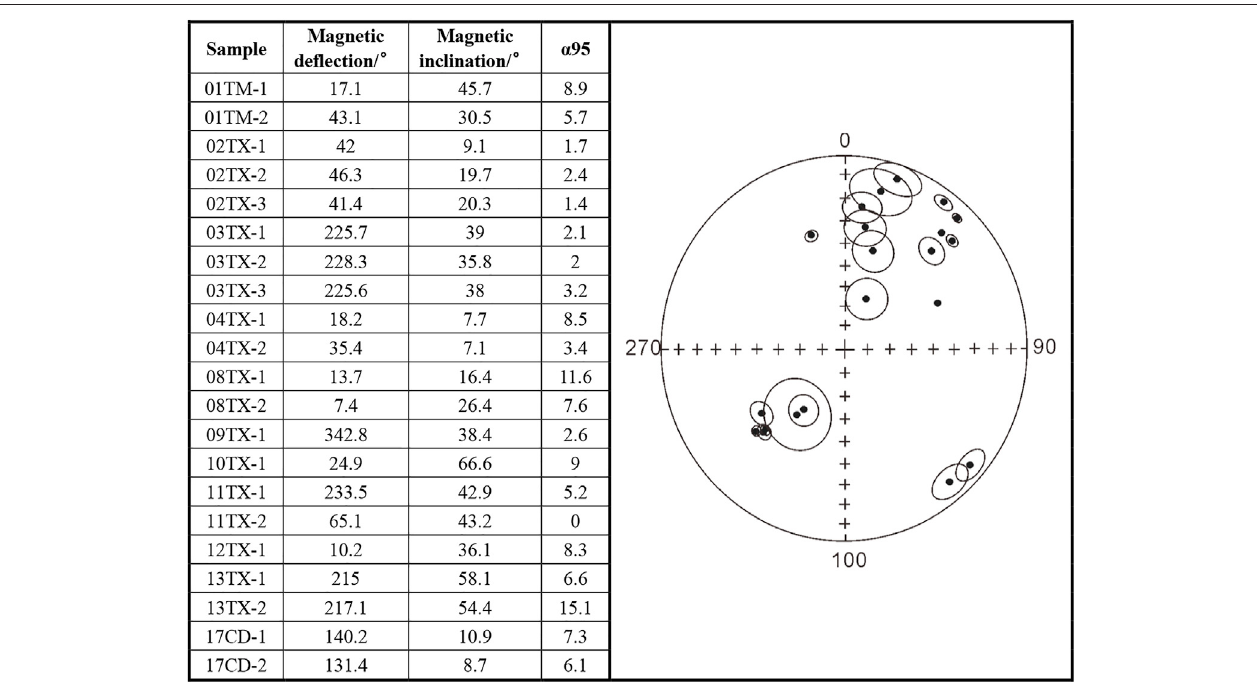
FIGURE 14 | Result of paleomagnetic orientation experiment and stereographic projection of fracture strike.